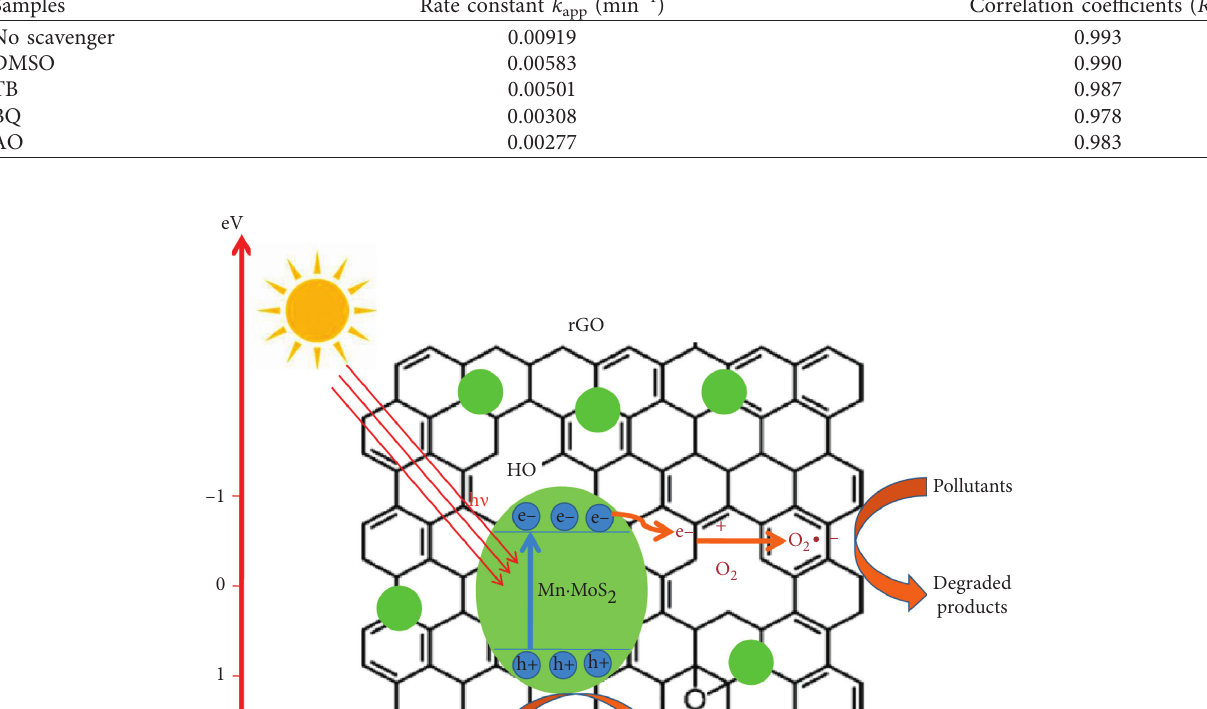
Table 2: Rate constant for the photocatalytic degradation of RhB on 3%MMS/rGO with and without the addition of the scavengers. Samples